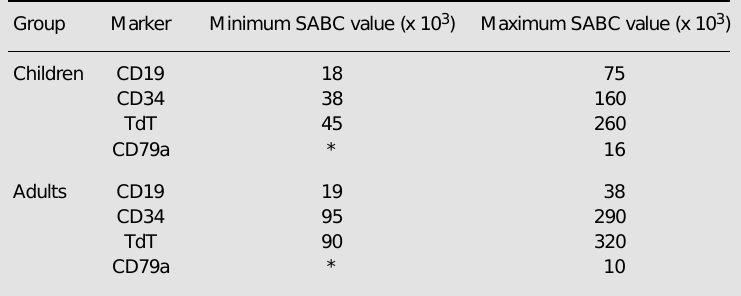
Table 4 - Cut-off values for CD19, CD34, TdT and CD79a expression in normal bone marrow precursors.